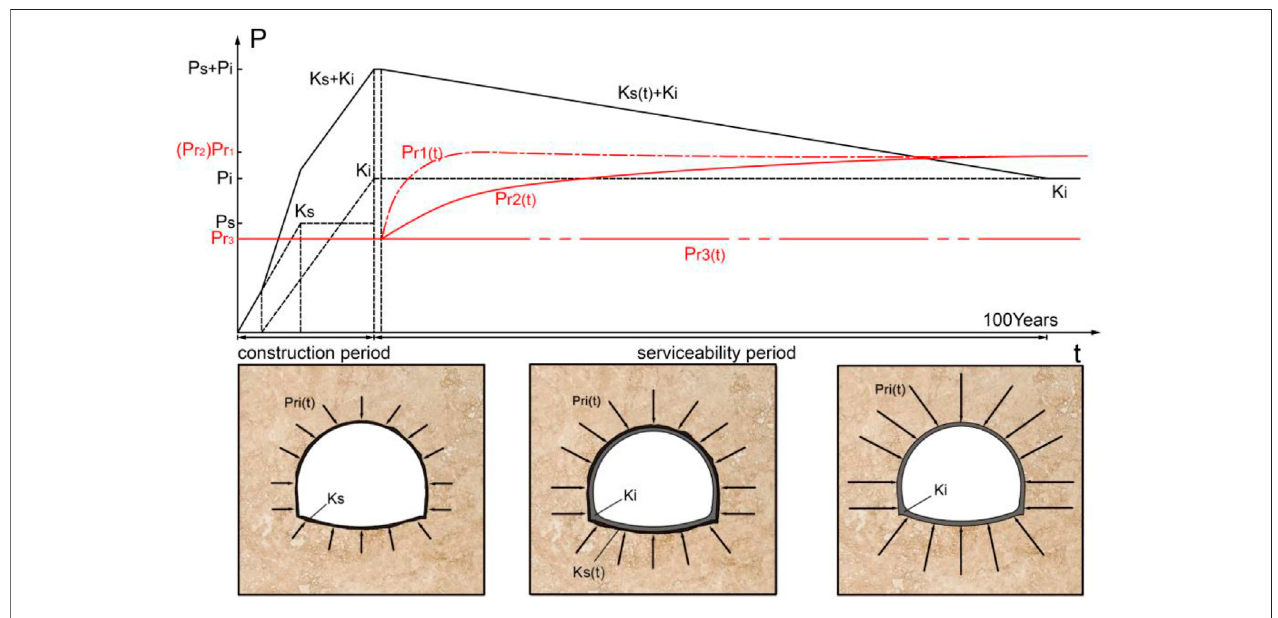
FIGURE 2 | Deterioration mechanisms of the rock mass and lining.